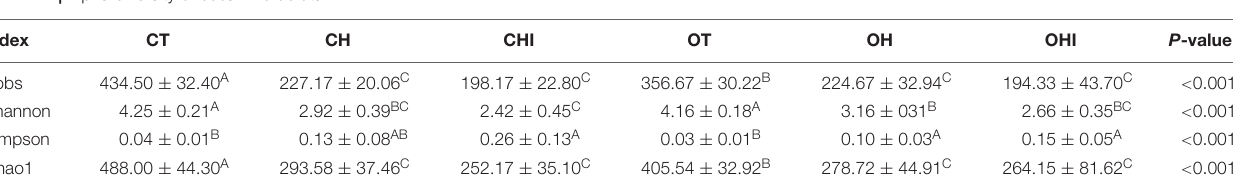
FIGURE 1 | Effect of high-fat diet and inulin supplementation on body weight. (A) Effect of normal diet, high-fat diet, and high fat with inulin diet on wild-type mice. (B) Effect of normal diet, high-fat diet, and high fat with inulin diet on leptin knockout mice. “*” indicates a significant difference compared with OT ( p < 0.05). TABLE 1 | Alpha diversity of cecal microbiota.